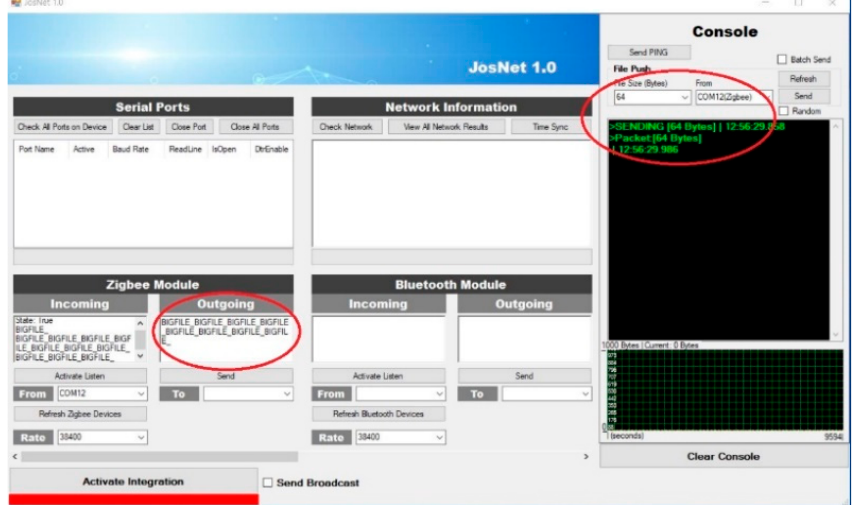
Figure 14. Source Zigbee external node (ZBx) sending 64 bytes of data through JosNet station 1 and station 2 to TH and BL.